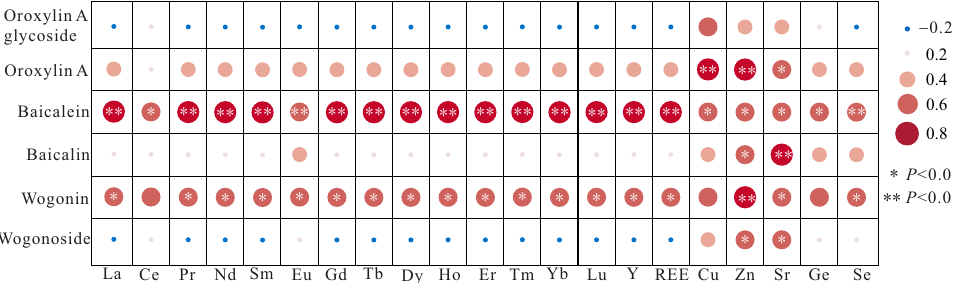
Figure 10. Pearson correlation analysis between flavonoid compounds and micronutrient elements in the roots of Scutellaria baicalensis .